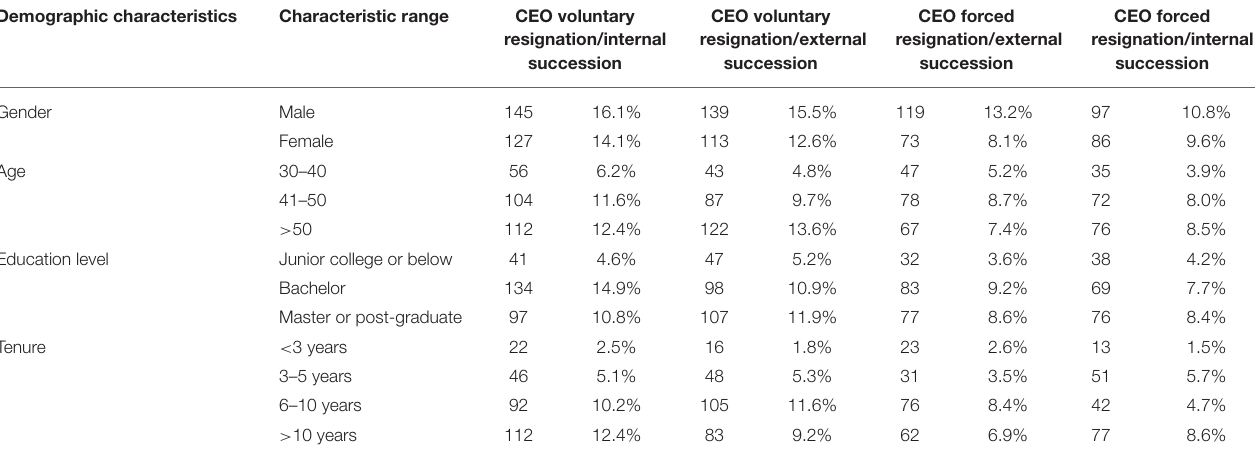
TABLE 1 | The descriptive statistics of the